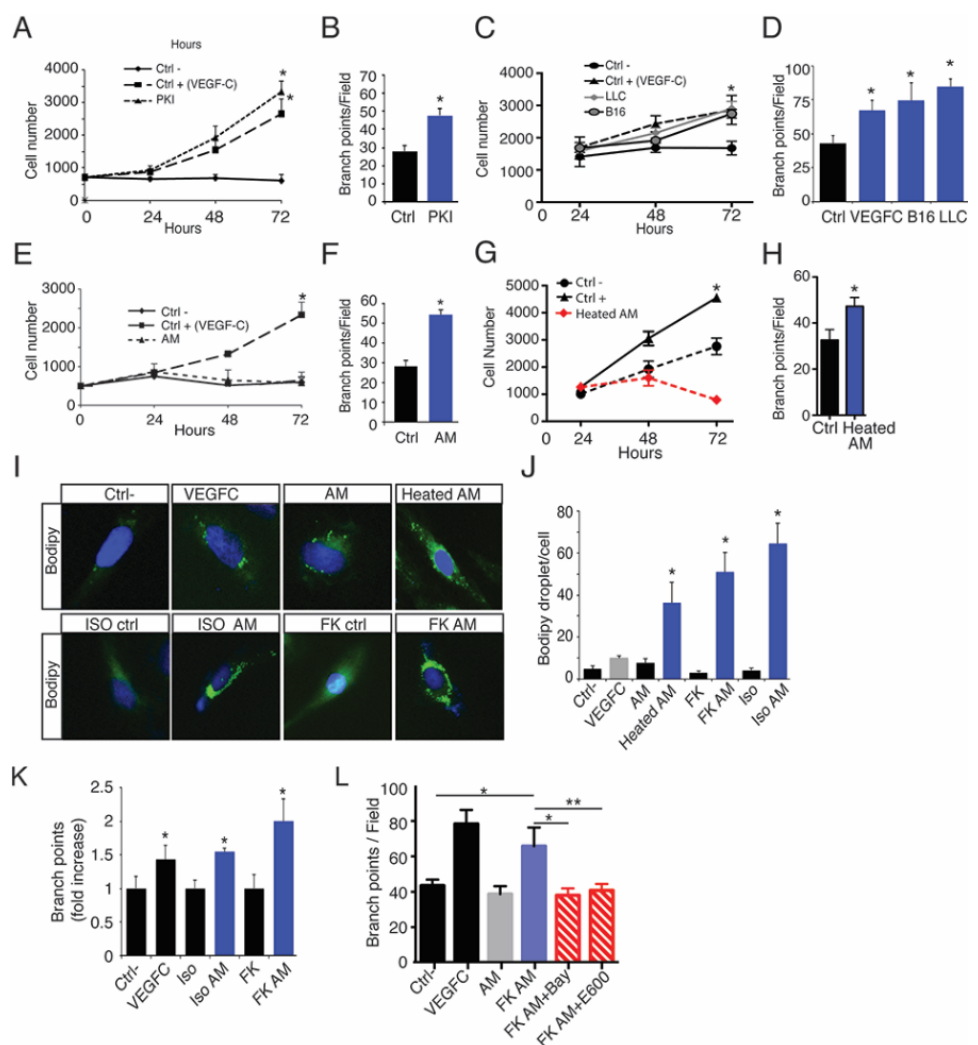
Figure 6. Exogenous FFA are uptaken by LEC to stimulate lymphatic sprouting. ( A ) Proliferation of PKI conditioned media-stimulated LECs (* p < 0.05). ( B ) Quantification of LEC branch point formation stimulated by PKI conditioned media (* p < 0.05). ( C ) Proliferation of LLC and B16 conditioned media-stimulated LECs (* p < 0.05). ( D ) Quantification of LEC branch point formation stimulated by LLC and B16 conditioned media (* p < 0.05). ( E ) Proliferation of LECs stimulated by Adipocyte Media (AM) (* p < 0.05). ( F ) Quantification of LEC branch point formation stimulated by